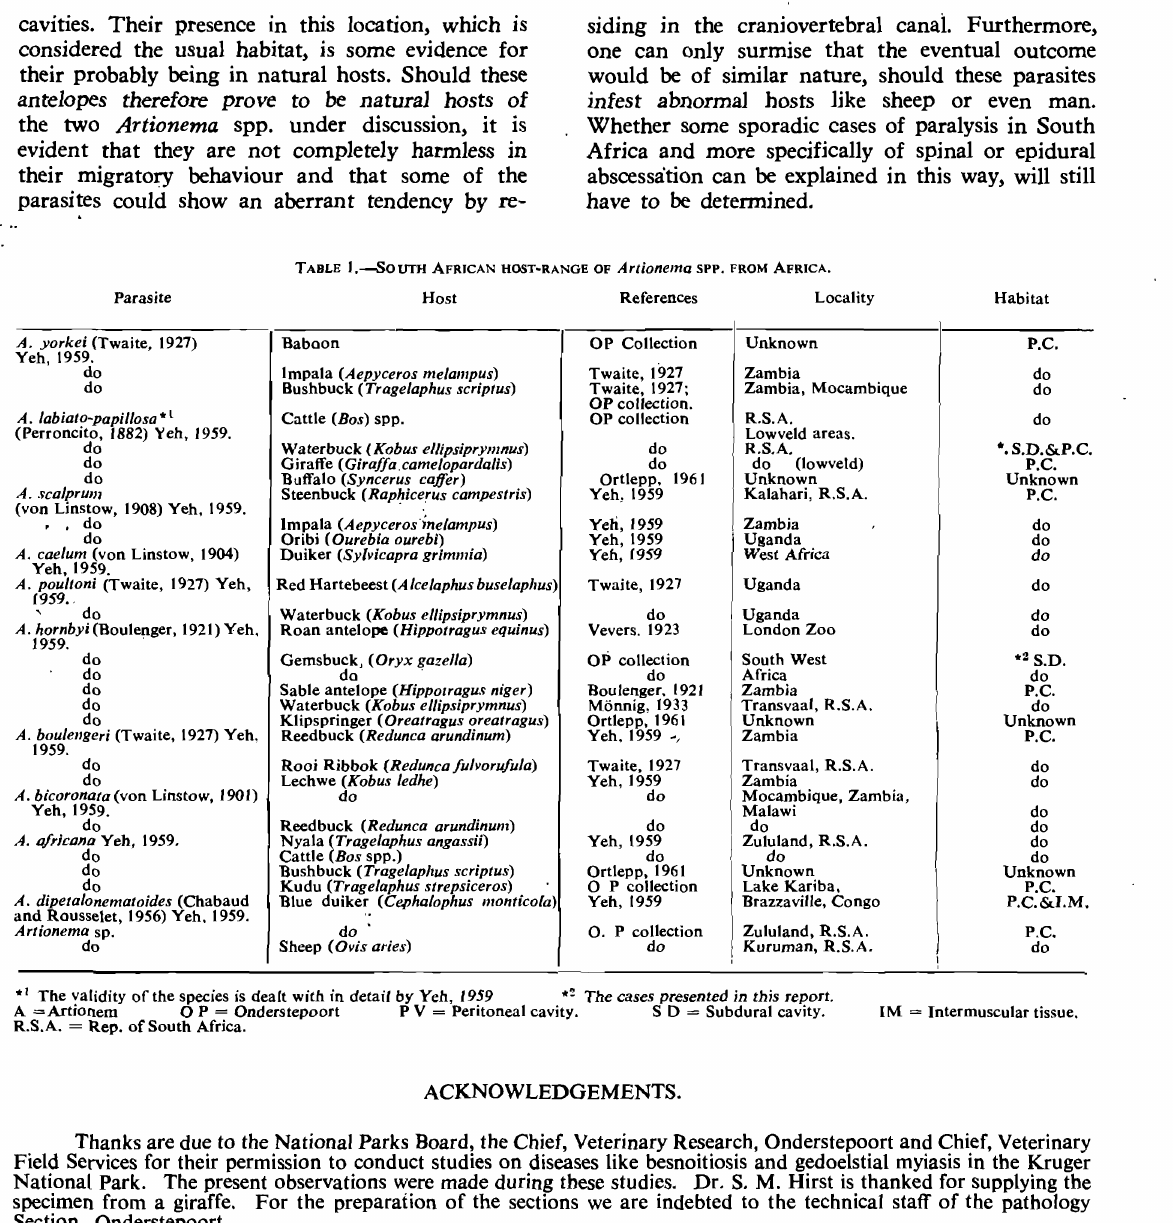
TABLE 1 ,--So UTH AFRICAN HOST .. RANGE OF A rlionema SPP. FROM